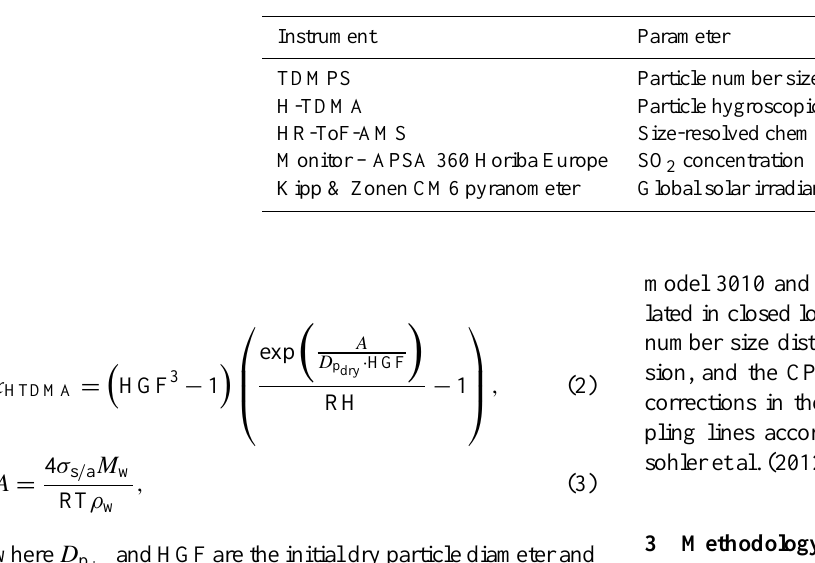
Table 1. Summary of instruments and parameters used in this